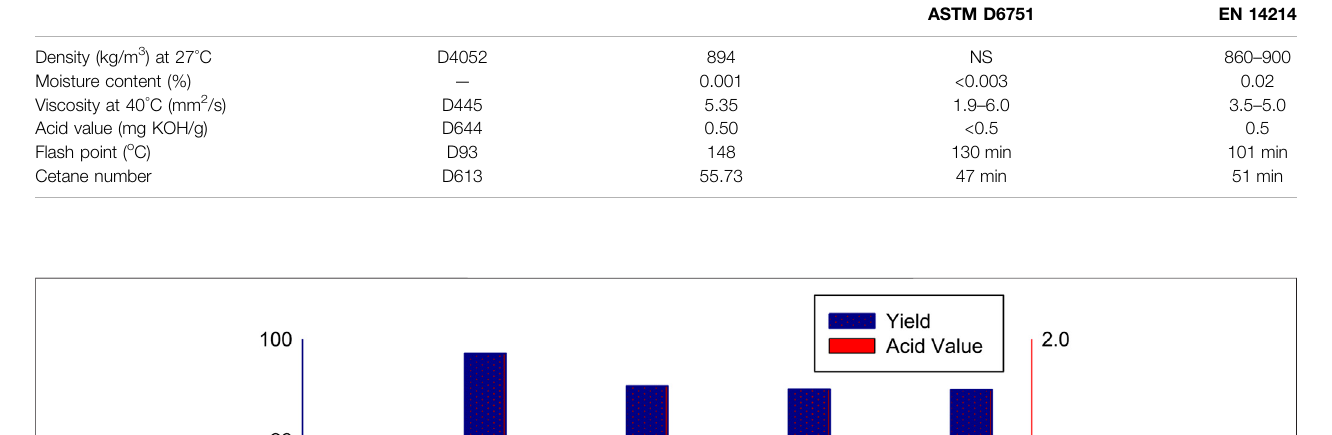
TABLE 5 | Physicochemical properties of neem seed oil biodiesel. Property (unit)